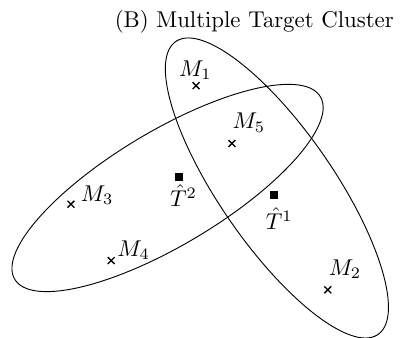
Figure 10. Examples of validation gates for single and multiple target clusters.